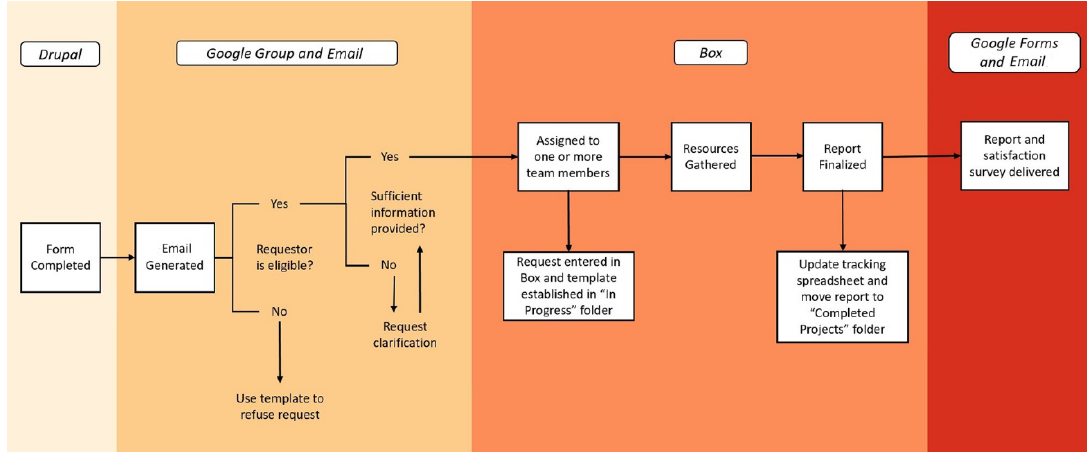
Figure 1 Workflow to ingest requests and produce